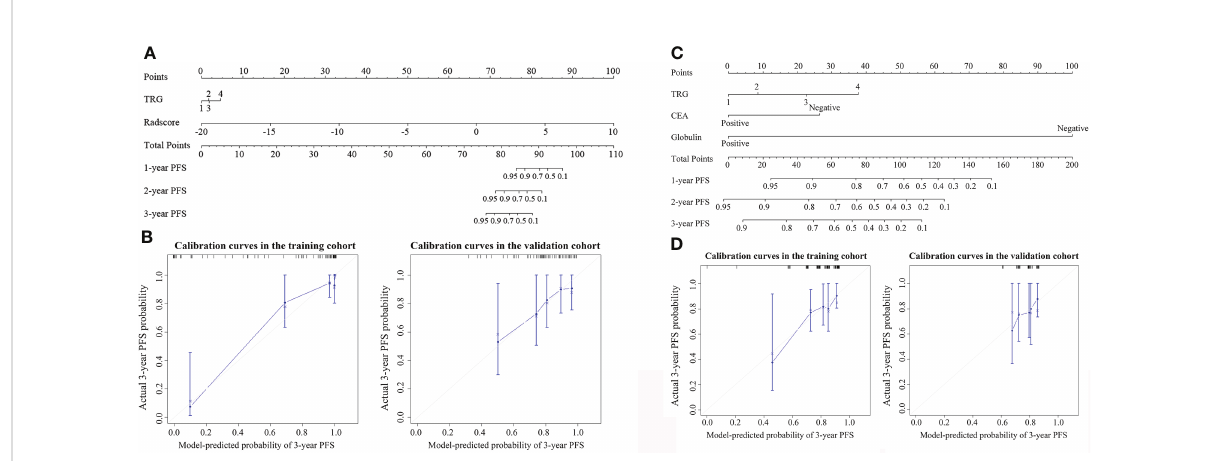
FIGURE 1 Nomogram for 3-year progression-free survival (PFS) in (A) iPostM and (C) PostM2. The nomogram allows the user to determine the probability of 3-year PFS corresponding to a patient ’ s combination of covariates. Calibration curves for predicting 3-year PFS in (B) iPostM and (D) PostM2 in the training and validation cohorts. The y-axis shows observed survival estimated using the Kaplan-Meier method, and the x-axis shows predicted survival calculated using the prognostic model. The closer fi t to the diagonal dotted line indicates a better assessment. iPostM, integrated prognostic model combining tumor regression grade (TRG) and radiomic signature; PostM2, post-treatment clinical prognostic model without pathologic